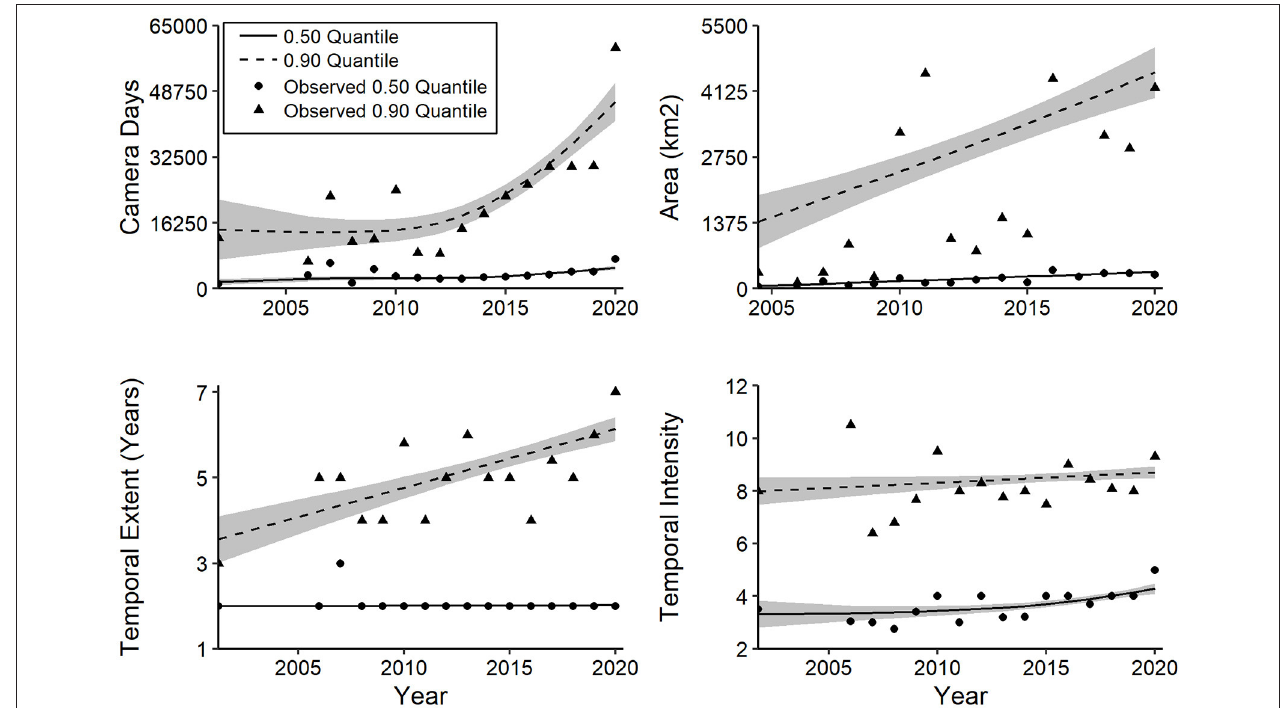
FIGURE 12 | Generalized additive quantile models for trends in camera-trapping effort and scale based on median and 0.90 quantiles. Details of model fit are provided in the text and Supplementary Table 1d . Shaded regions represent standard